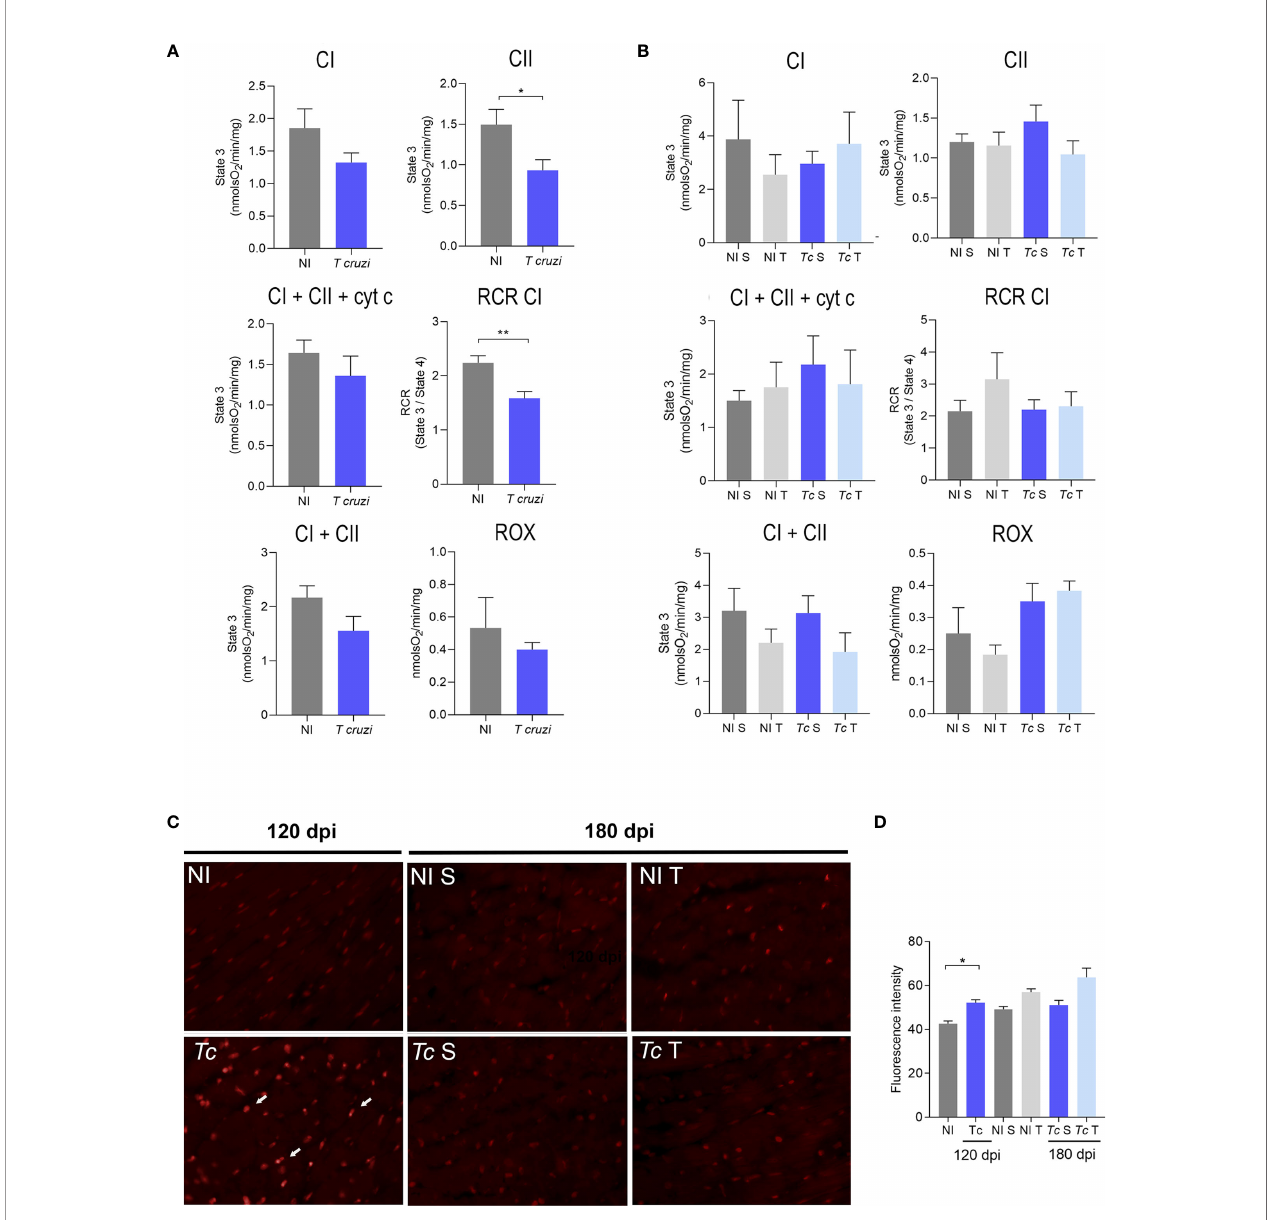
FIGURE 5 | Effects of T. cruzi infection and physical exercise on mitochondrial oxygen consumption and ROS production in heart tissue of C57BL/6 mice. (A, B) Oxygen consumption at (A) 120 dpi and (B) 180 dpi. (C) Representative sections stained with DHE. (D) Densitometric analysis of DHE staining. White arrows indicate DHE staining. The data are represented as means ± SEM. Data represent six to eight mice per group. Signi fi cant differences between infected and uninfected groups *p < 0.05; **p < 0.01 ( Mann – Whitney; Kruskal – Wallis test, Dunn ’ s posttest